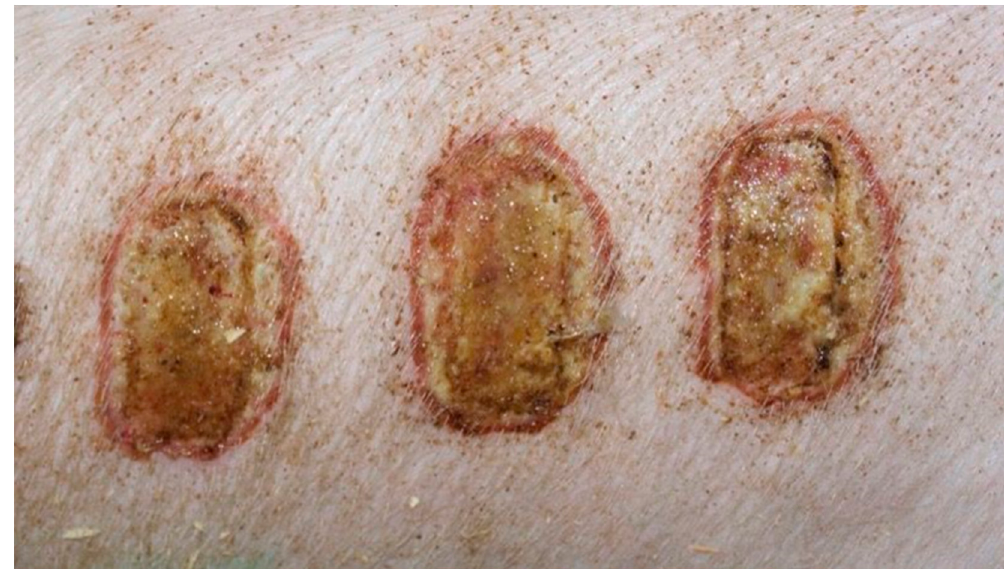
Figure 2. Group D2—burn wound treated with the 1% nanosilver ointment on day 5.